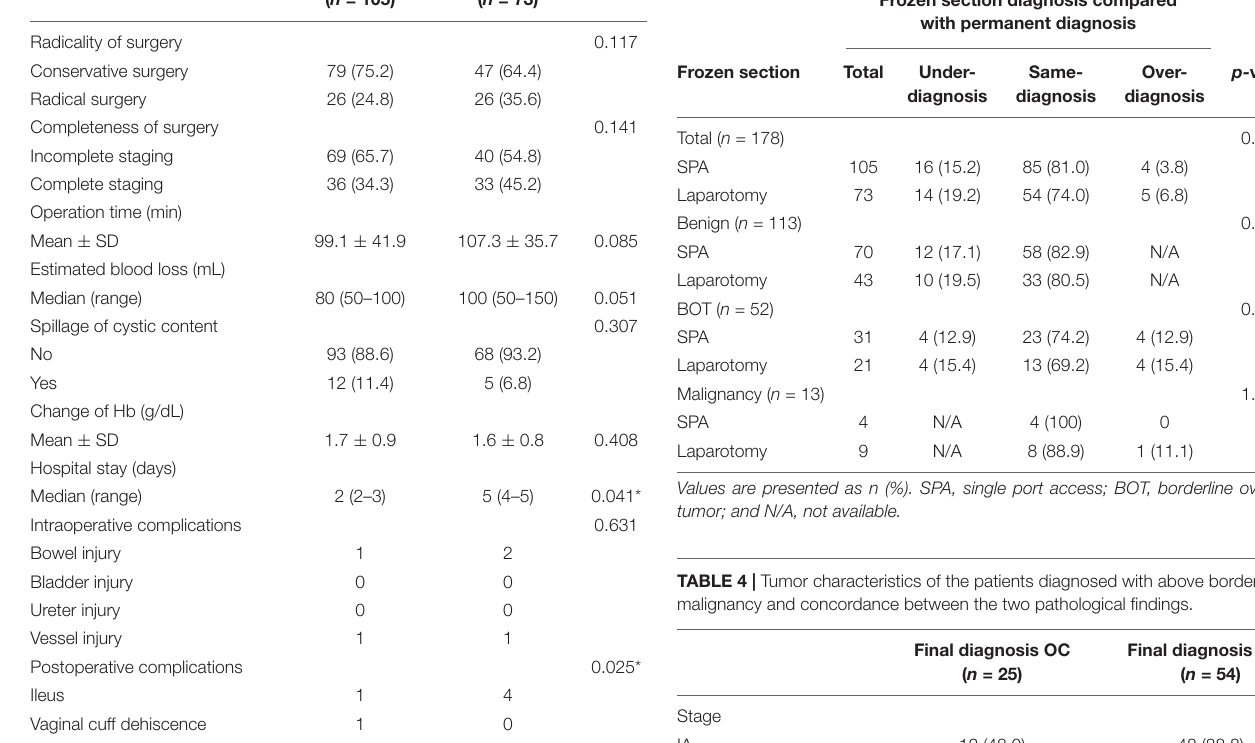
according to the surgical approach. Frozen section diagnosis compared with permanent diagnosis